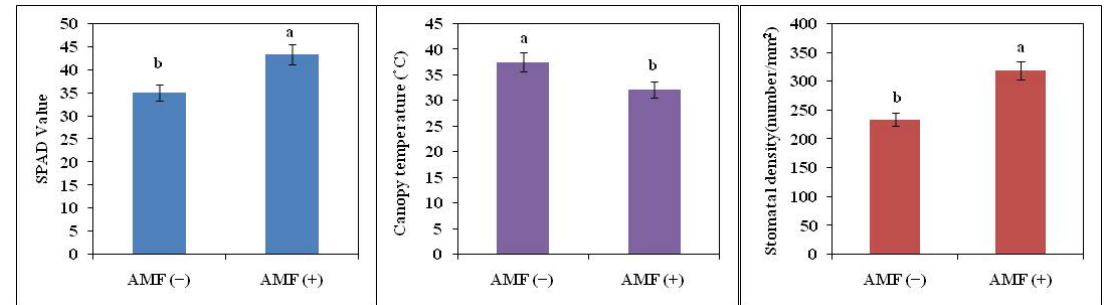
tical bar indicates ± SE for the mean. The means for each main treatment followed by the different letters are significantly different ( p ≤ 0.05).